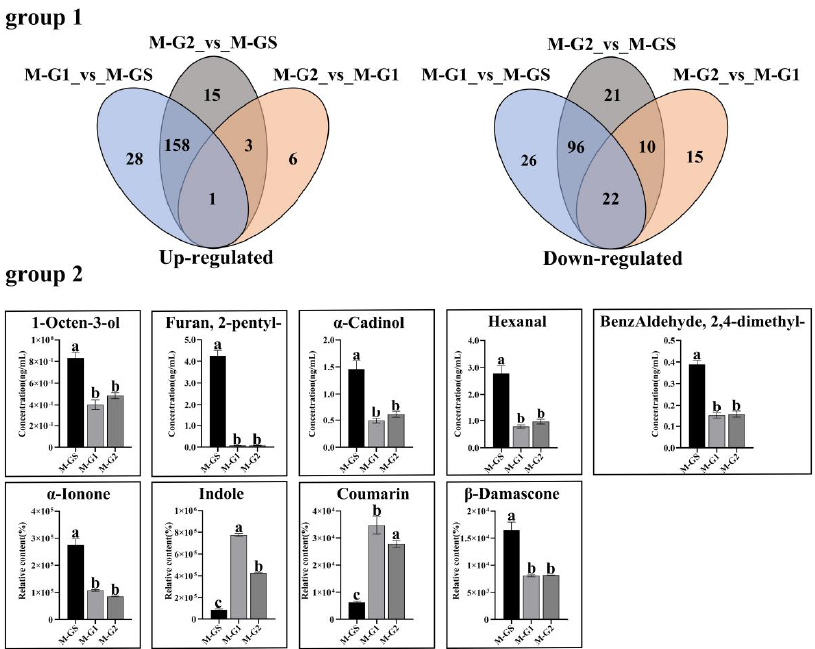
Figure 4. Venn diagram and important differential compounds of different grades of Shandong matcha ( group 1 ). Venn diagram of differential compounds in Shandong matcha ( group 2 ). The reported key aroma components of Japanese Matcha detected in this study. Different lowercase letters represent different significantly on p < 0.05 level .